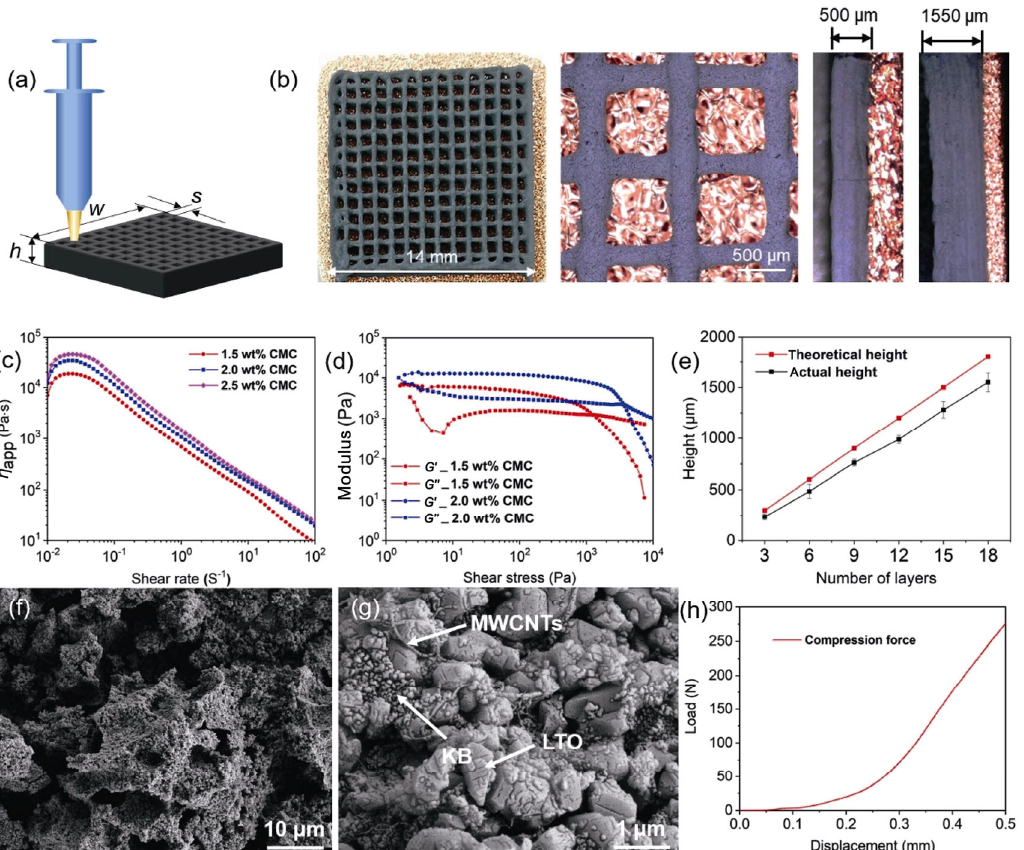
Fig. 4 Morphologies, ink rheological properties, microstructures, and compressive strength of 3D printed grid porous electrodes: (a) schematic of the printing process; (b) top view, magnified top view, and side view of the electrodes; (c) variation of apparent viscosity with shear rate; (d) storage modulus G ′ and loss modulus G ′′ ; (e) variation of electrode height with number of layers; (f, g) SEM microstructures; and (h) compressive behavior of printed electrodes with 18